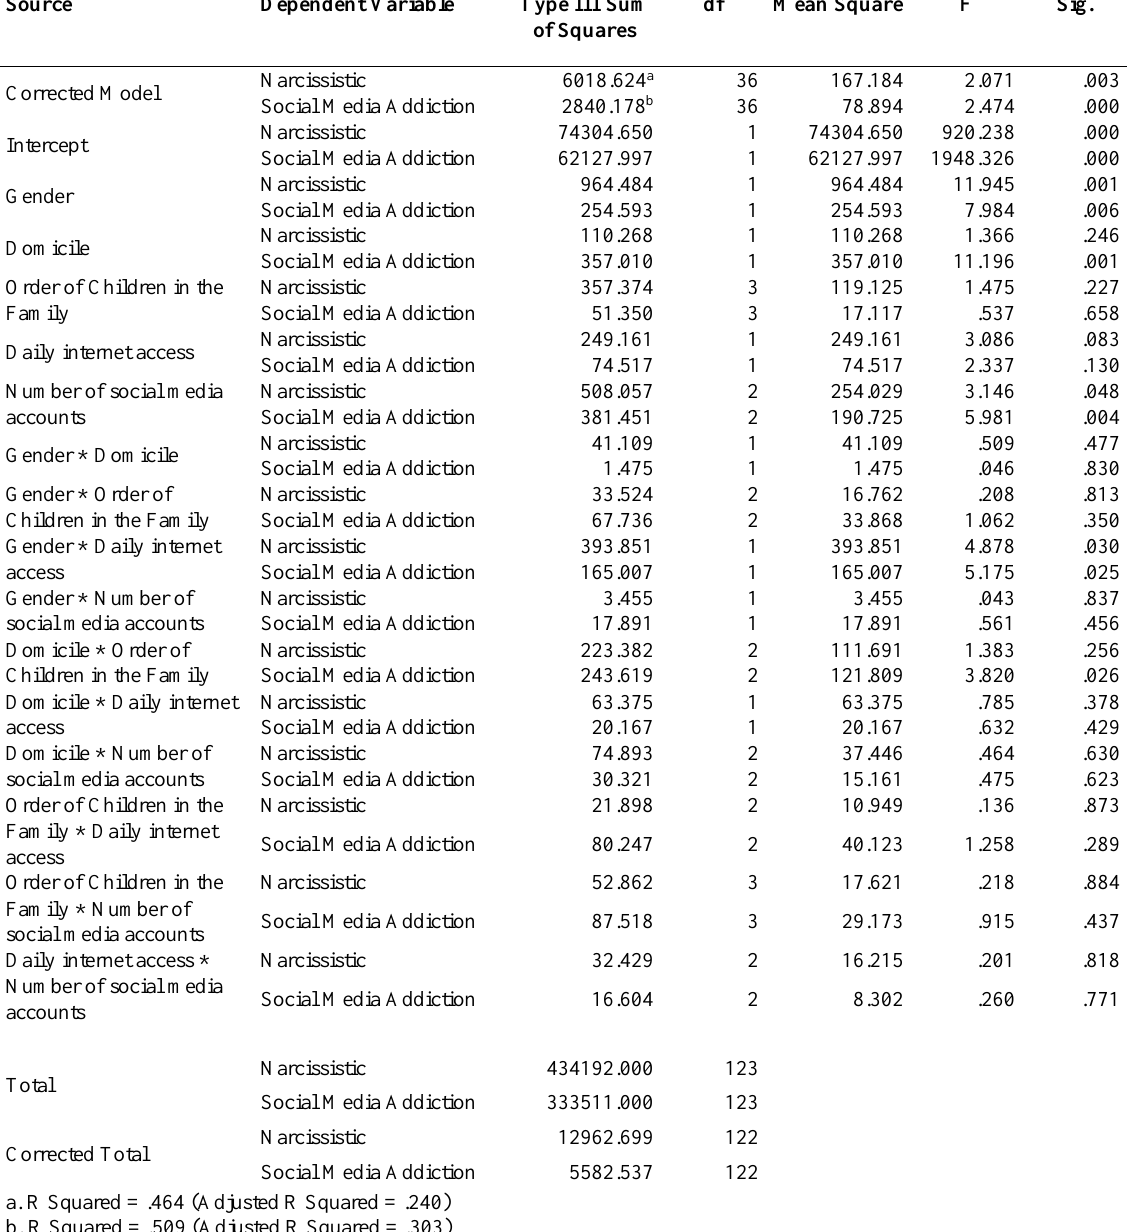
Table 6 . Results of Multivariate One-Way Analysis of Variance Model